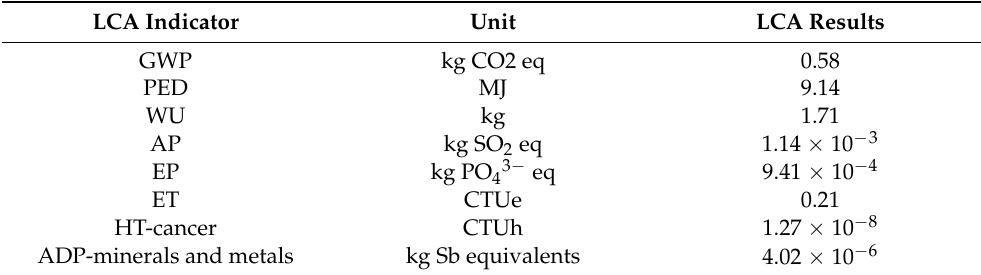
Table 4. Results for scenario 2.